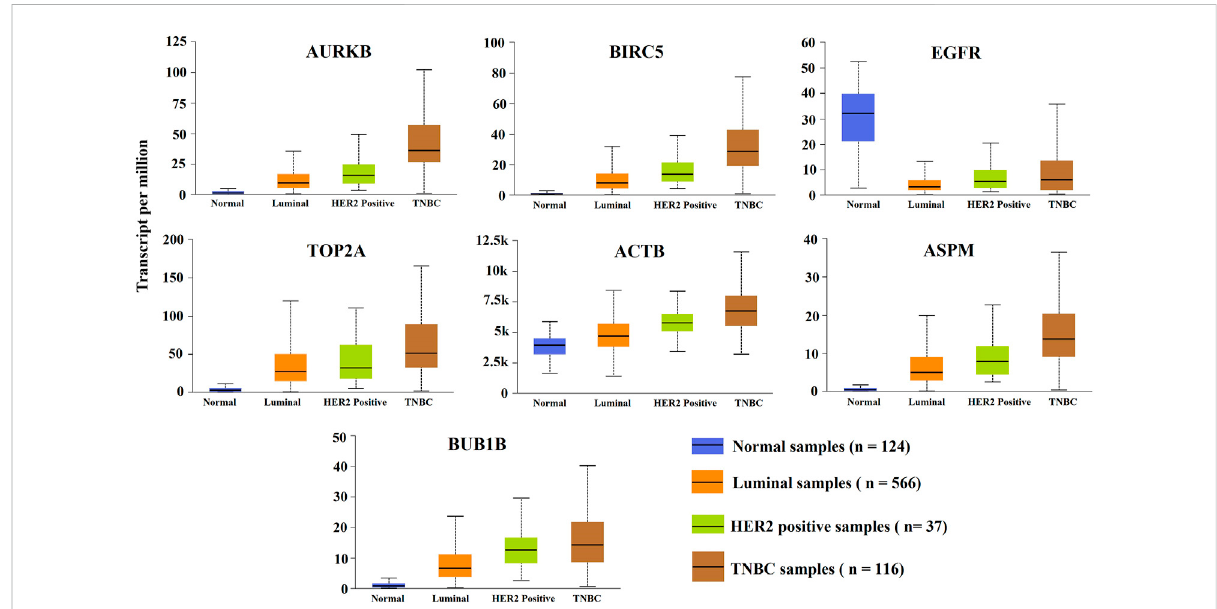
FIGURE 5 Expression levels ’ analysis of KGs between the normal group and the three major subtypes of BC (luminal, HER2-positive, and triple- negative BC).